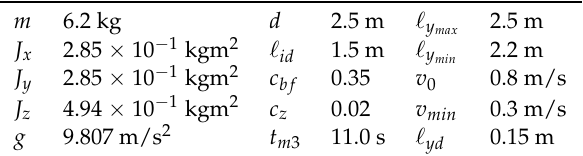
Table 1. Parameters of the quadrotor and mapping used in numerical